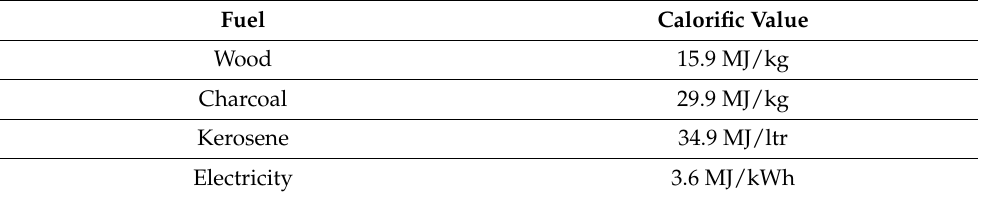
Table 4. Calorific values for major fuel sources. Data from World